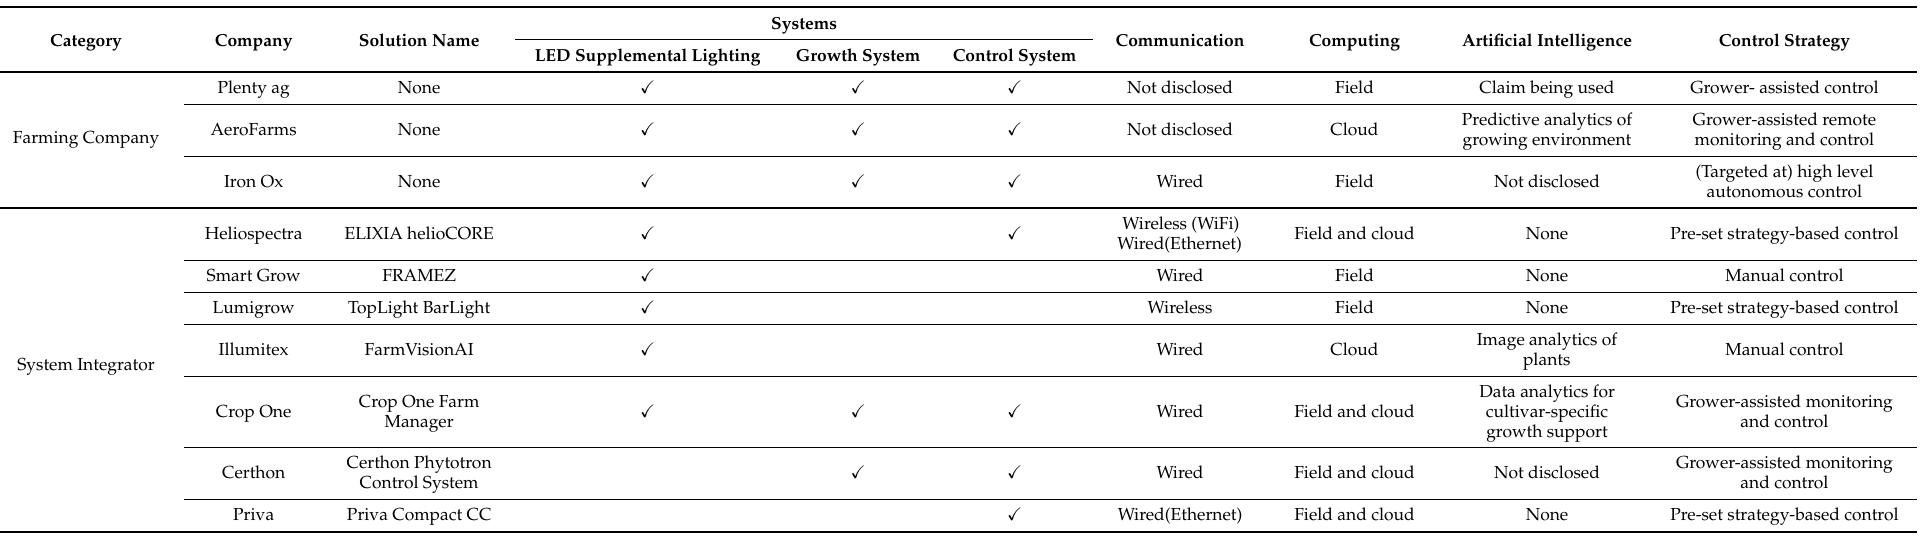
Table 1. Leading farming companies and system integrators in the plant factory and vertical farming